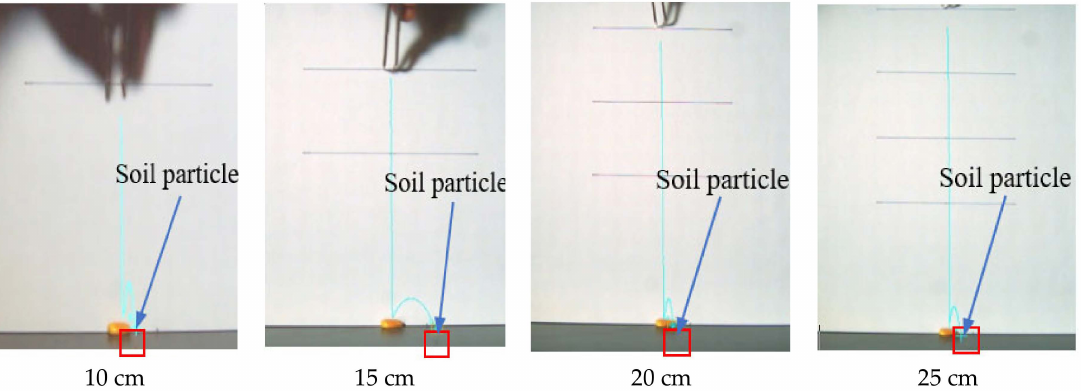
Figure 5. Image analysis of high-speed